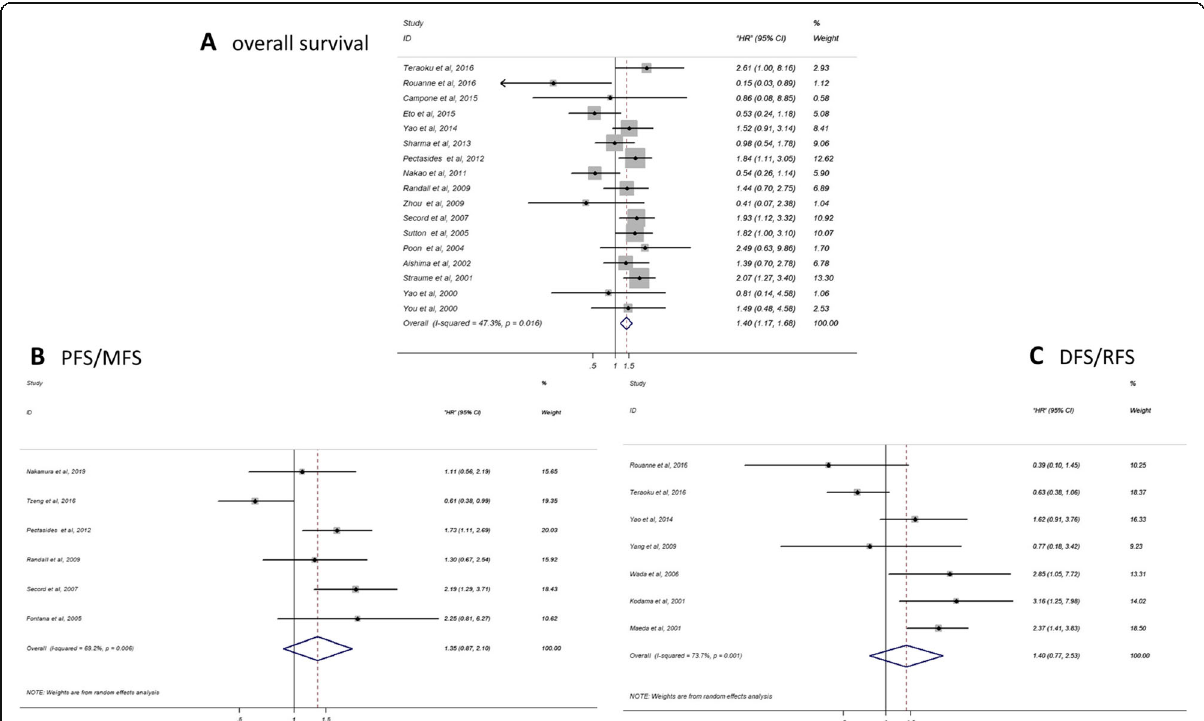
Fig. 2 Forest plots of merged analyses estimated for the correlation between survival and TSP-1 expression. (A) Forest plot to assess the OS analysis; (B) Forest plots for the PFS/MFS analysis; (C) Forest plots of the DFS/RFS analysis. Abbreviation: OS, overall survival; PFS, progression-free survival; MFS, metastasis-free survival; RFS, recurrence-free survival; DFS, disease-free survival; HR, Hazard